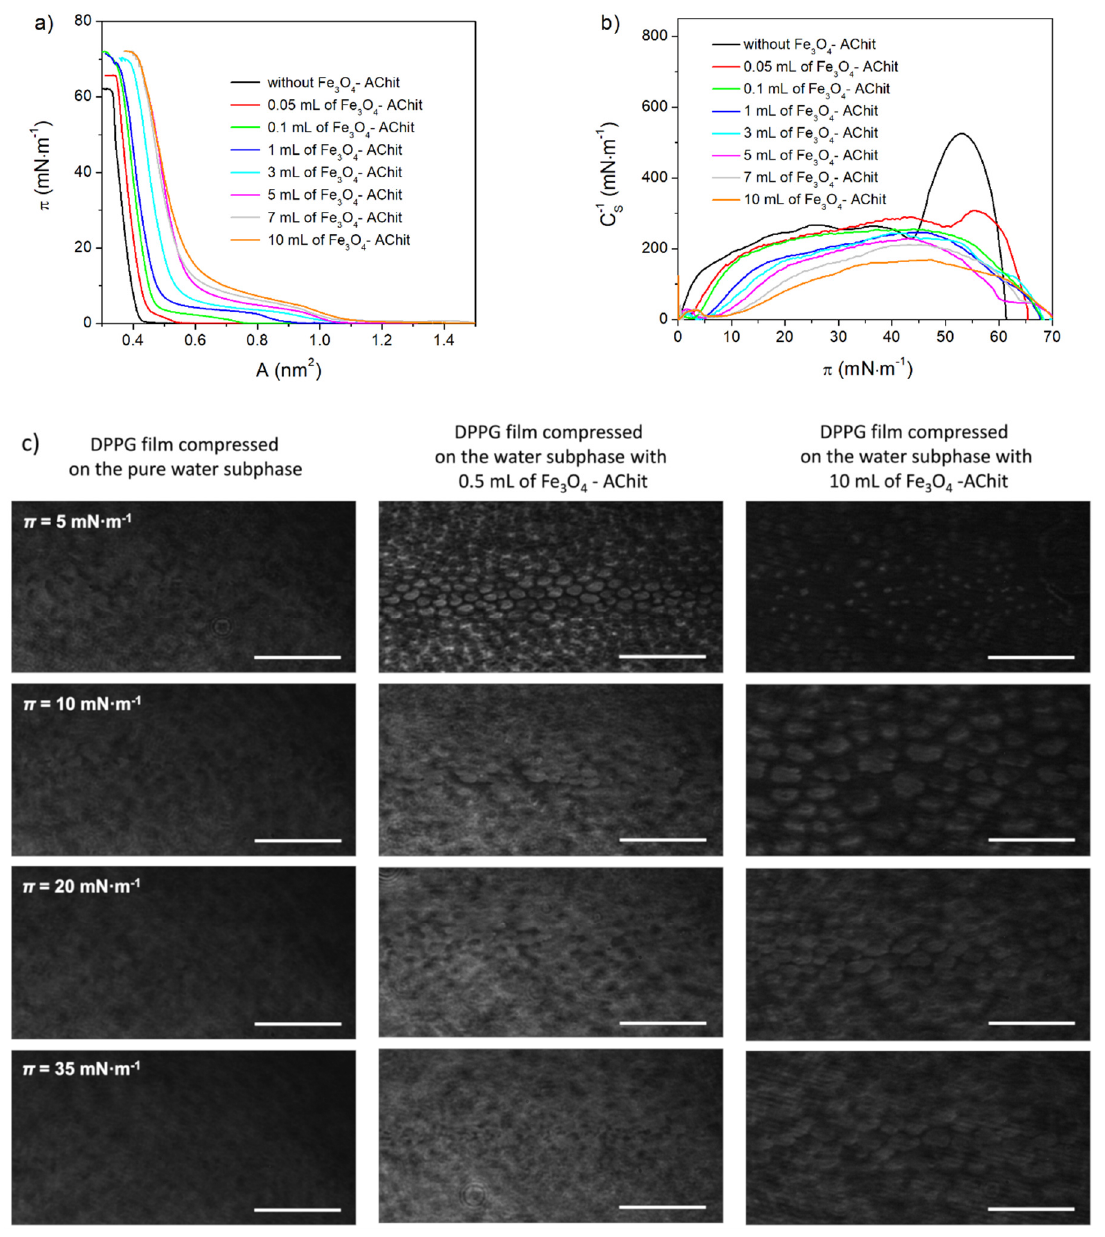
Figure 2. π -A isotherms ( a ), C S − 1 - π dependences ( b ), and Brewster angle microscope (BAM) images ( c ) recorded during compression of the DPPG monolayers on the water subphase with different concentrations of the Fe 3 O 4 -AChit nanoparticles. Length of scale bar in BAM images—100 μ m.